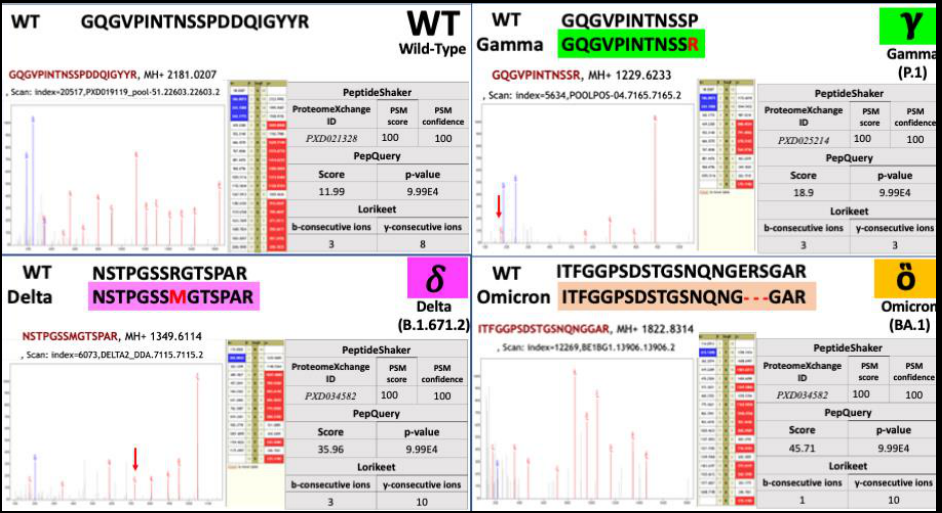
Figure 3 . Representative MS/MS spectra of SARS-CoV-2 verified peptides from the clinical samples. The figure shows the manually validated and annotated MS/MS spectra resulting in these peptide sequence identifications. Representative variant-specific peptide sequences from the Nucleocapsid protein are shown, along with their alignment to the wild-type sequences and scores from the discovery, verification, and validation steps. The peptides in black font are from wild-type SARS-CoV- 2, while the variant peptides are colored-coded; assignments to WHO-designated variants are shown as Gamma (green), Delta (pink), and Omicron (orange). All the amino acid sequence mutations are marked with red text, and the red arrow within the annotated MS/MS spectra designates the detection of sequence fragments at m/z values specific to fragments carrying these